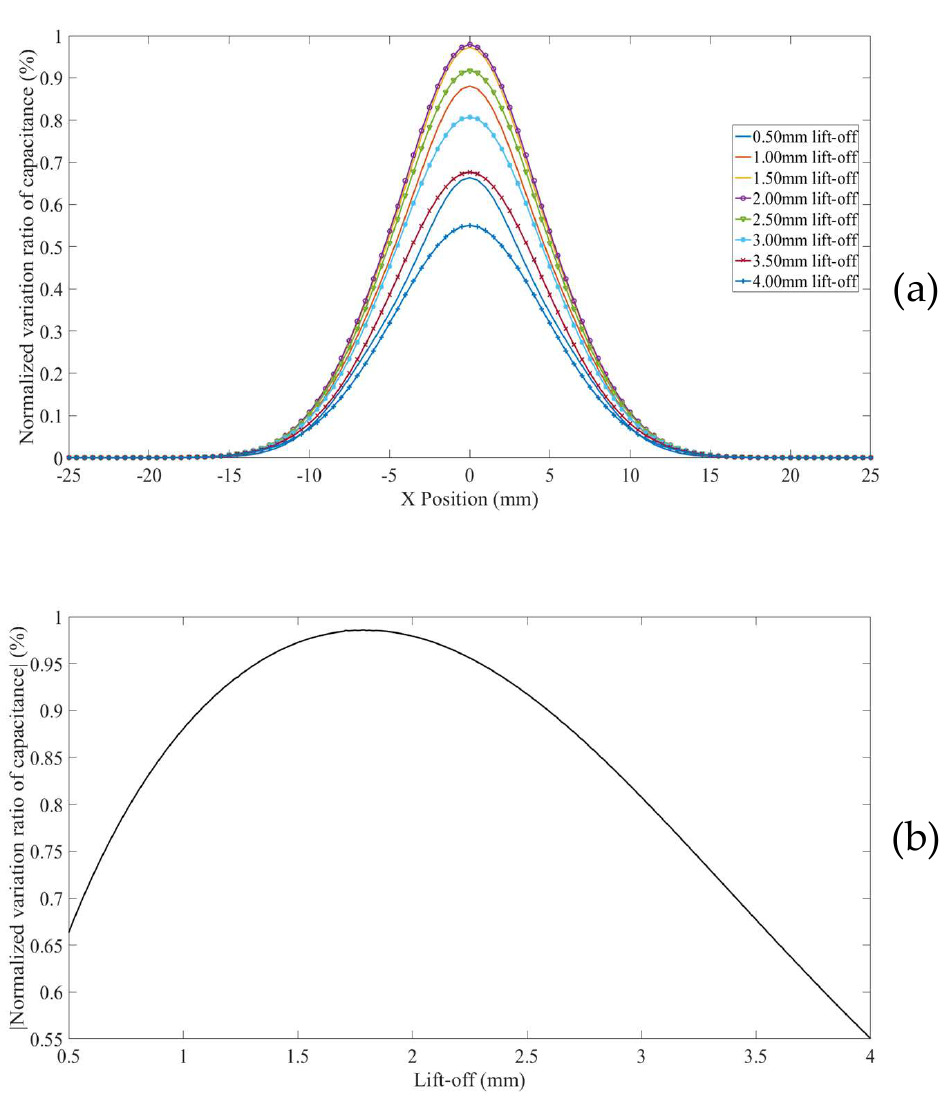
Figure 13. ( a ) NVR curves for Model 7 with lift-offs increased from 0.5 mm to 4 mm and ( b ) absolute values of the NVRs at the centre point against lift-offs.